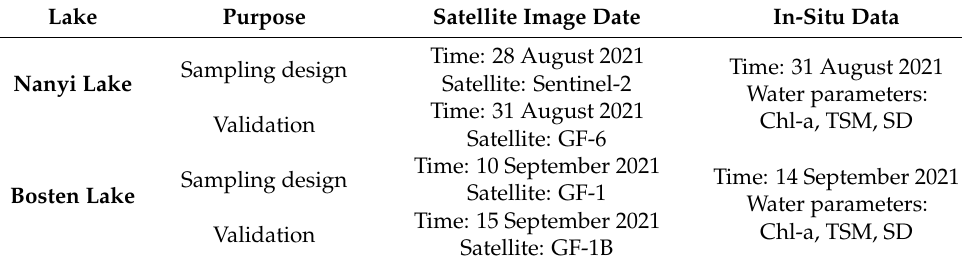
Sampling design